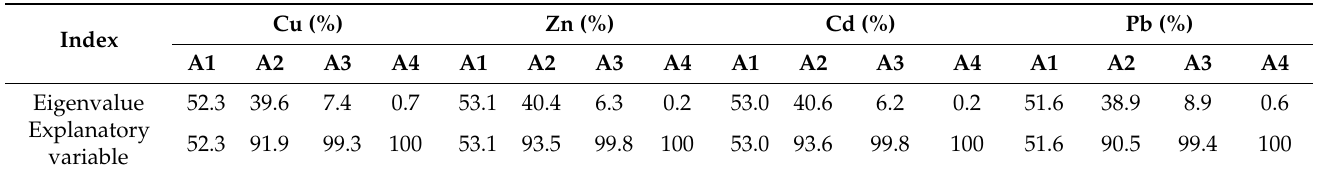
Table 8. Redundancy analysis (RDA) results of heavy metals and physicochemical property factors in